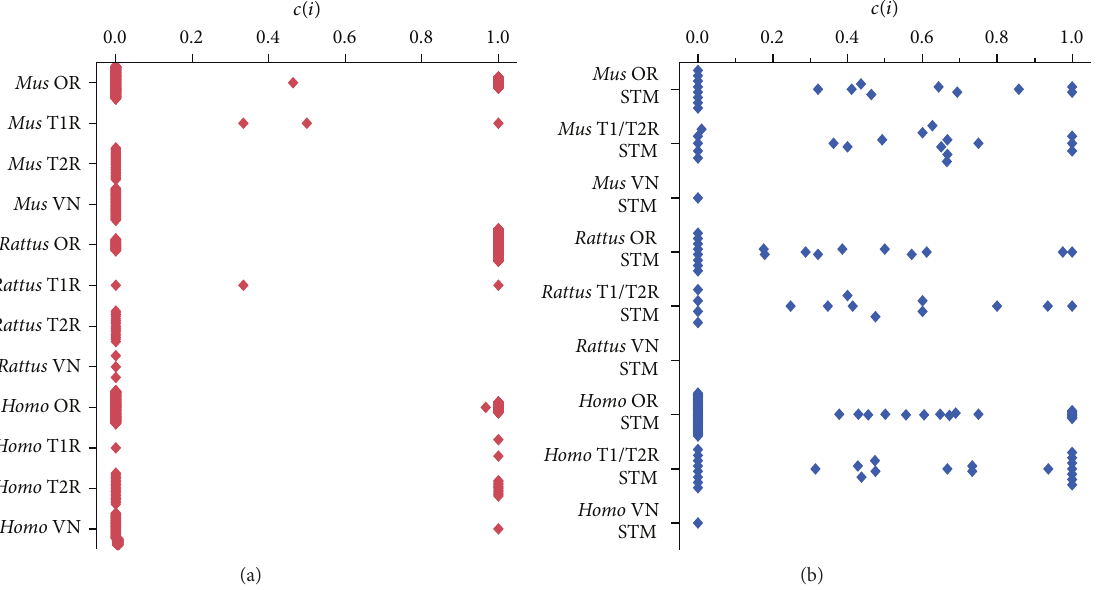
Figure 4: Clusterization values distribution for the chemoreceptors families (red) and their respective signal transducing machineries (blue). Values are shown in the vertical axis and the different subgroups are listed in the horizontal